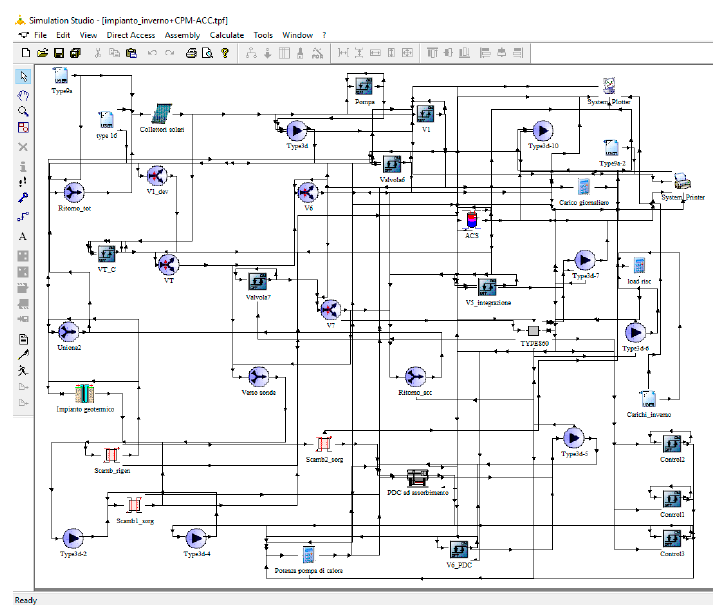
Figure 9. Schematic of the Trnsys project of the HVAC plant model.